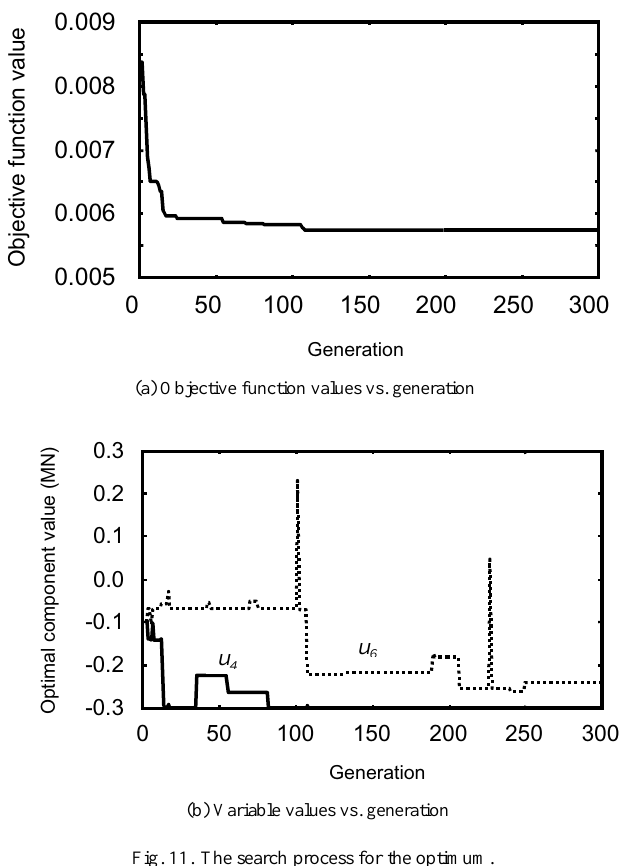
Fig. 11. The search process for the optimum.